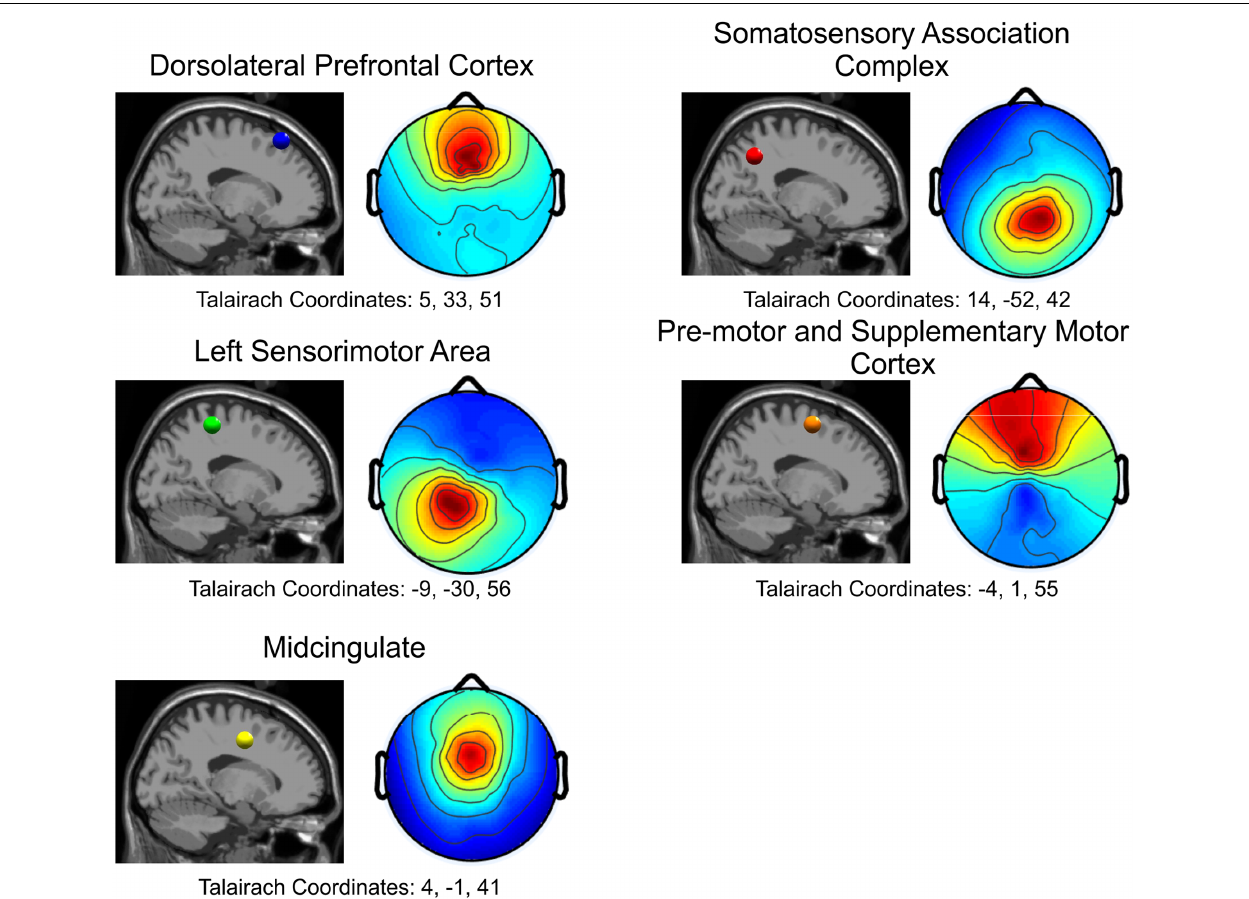
FIGURE 4 | Cortical locations for all five independent components in the sagittal plane and the corresponding topographical maps. Blue: Dorsolateral Prefrontal Cortex; Red: Somatosensory Association Complex; Green: Left Sensorimotor Area; Orange: Pre-motor and Supplementary Motor Cortex; Yellow: